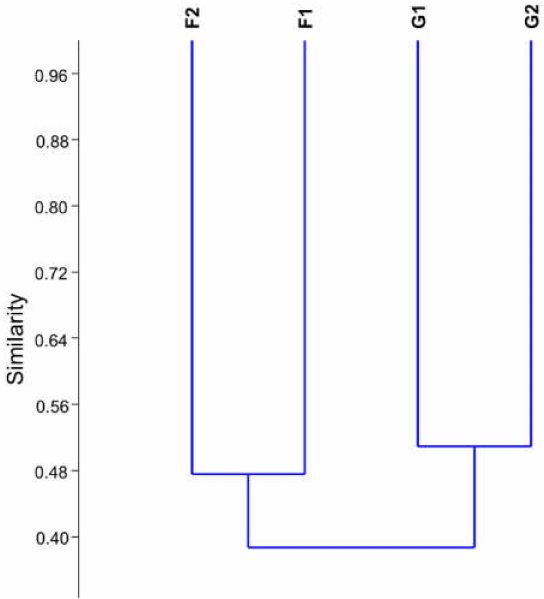
Figure 2. Similarity dendrogram from 16S rDNA sequencing of cave